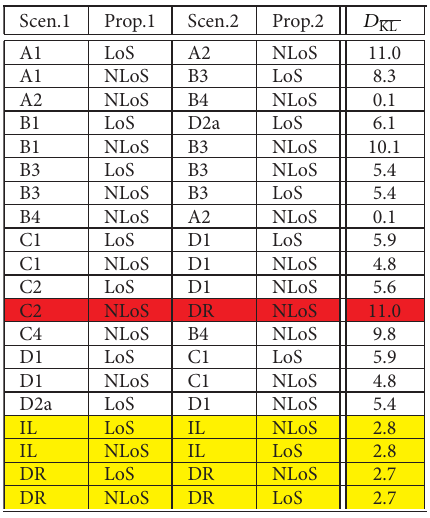
Table 5: Closest (scenario, propagation) pairs according to mean KL